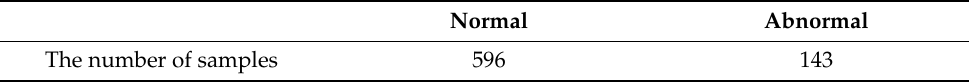
Table 1. The samples used for fixed-length